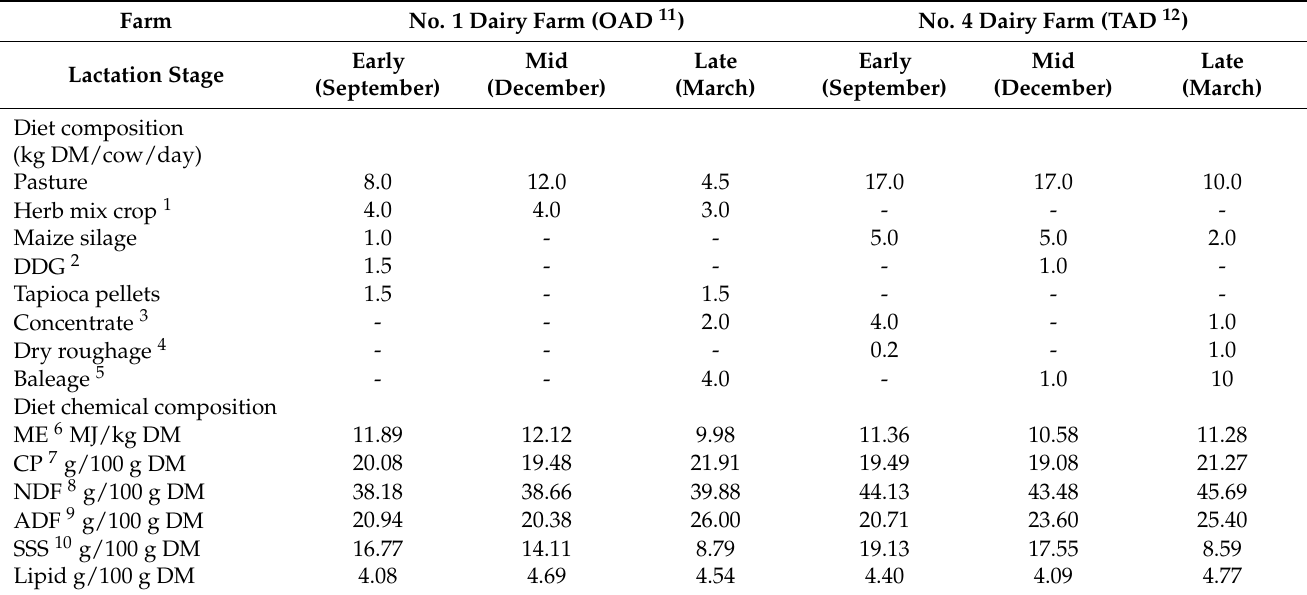
Table 1. Dietary and chemical composition of feed offered at the No. 1 and No. 4 dairy farms during the sampling periods (early, mid and late lactation) in the 2020–2021 production